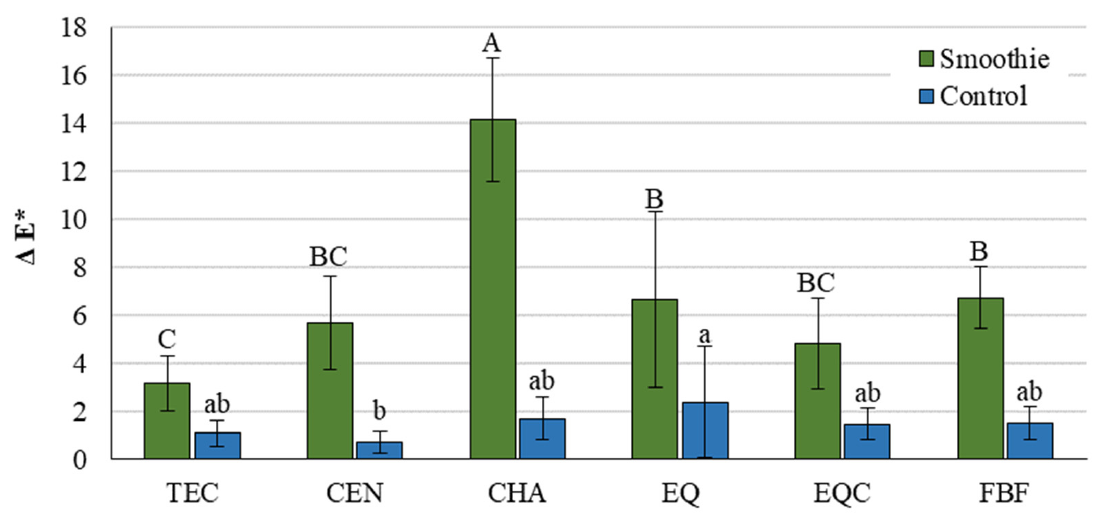
Figure 4. Delta E (mean values ± 1 standard deviation, n = 10) representing perceptible color change between 24 h and 1 month. All pairwise comparisons (smoothie vs. control) showed statistically significant differences. Same uppercase letters indicate statistically similar values within the smoothie group. Same lowercase letters indicate statistically similar values within the control group.